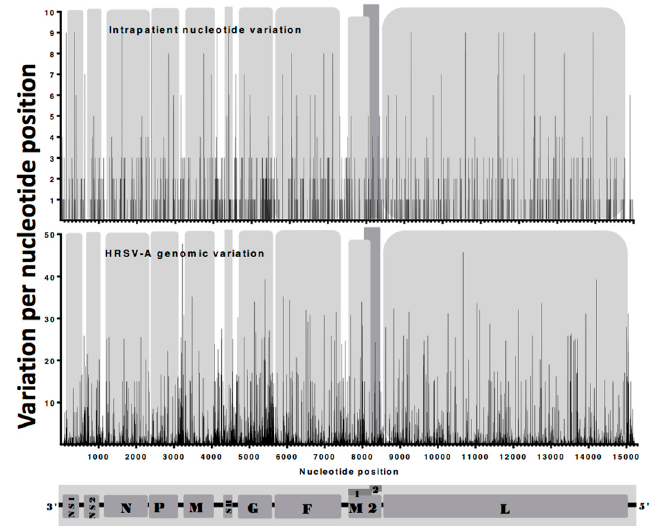
Figure 6. Intra- and inter-patient nucleotide variation. Intra patient variation across the length of the viral genome. The upper panel depicts the normalized intra-patient variation illustrating the number of minor variants at each nucleotide position plotted against the corresponding nucleotide position number. The lower panel depicts the inter-patient variation from a calculated consensus sequences estimated using 241 group A full genome sequences from the Gene-bank database .